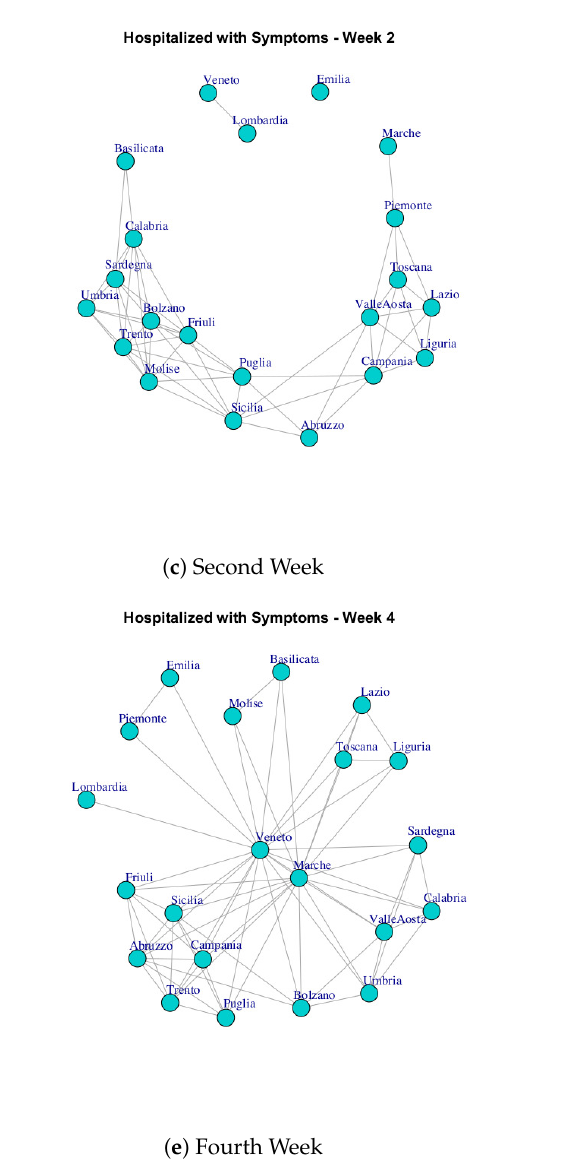
Figure 3. Evolution of Hospitalized with Symptoms